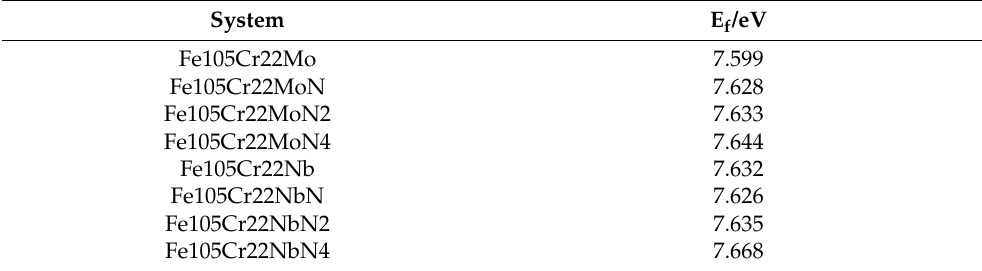
Table 4. Fermi energy levels of stainless